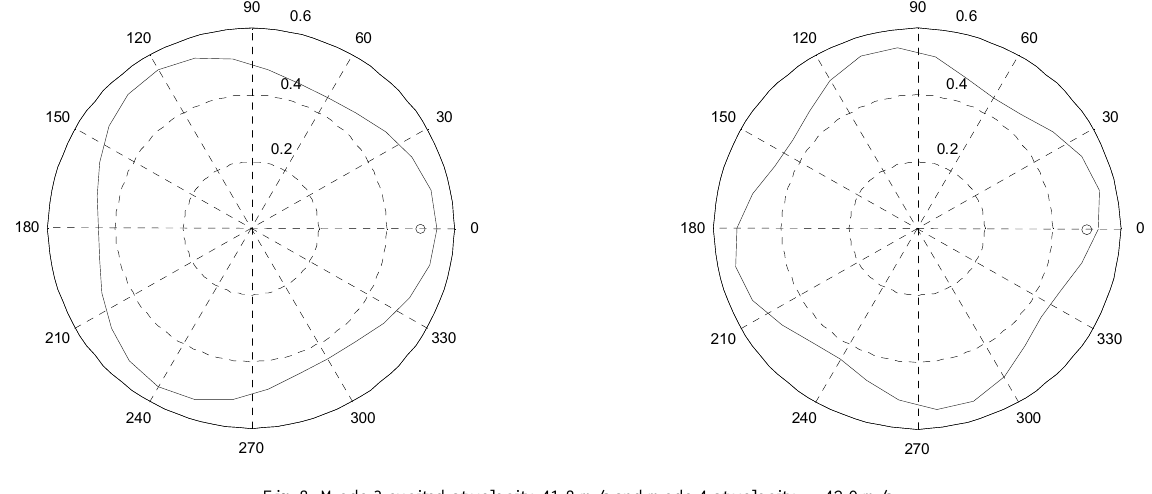
Fig. 8. Mode 3 excited at velocity 41.8 m/s and mode 4 at velocity = 42.9 m/s.